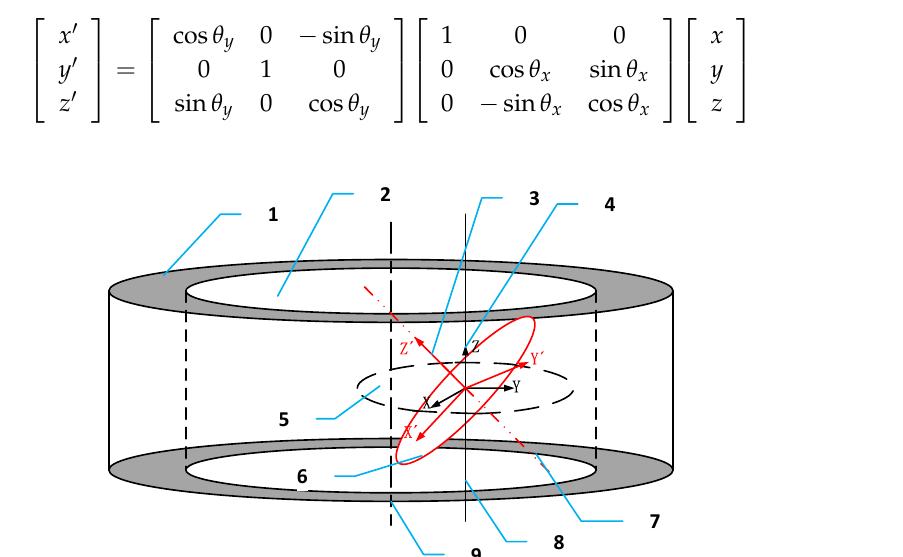
Figure 6. 1. Measured workpiece; 2. Inner hole; 3. Ideal coordinate system; 4. Real coordinate system; 5. Ideal coordinate plane; 6. Actual coordinate plane; 7. Rotation axis; 8. Ideal axis; 9. Axis of measured hole.